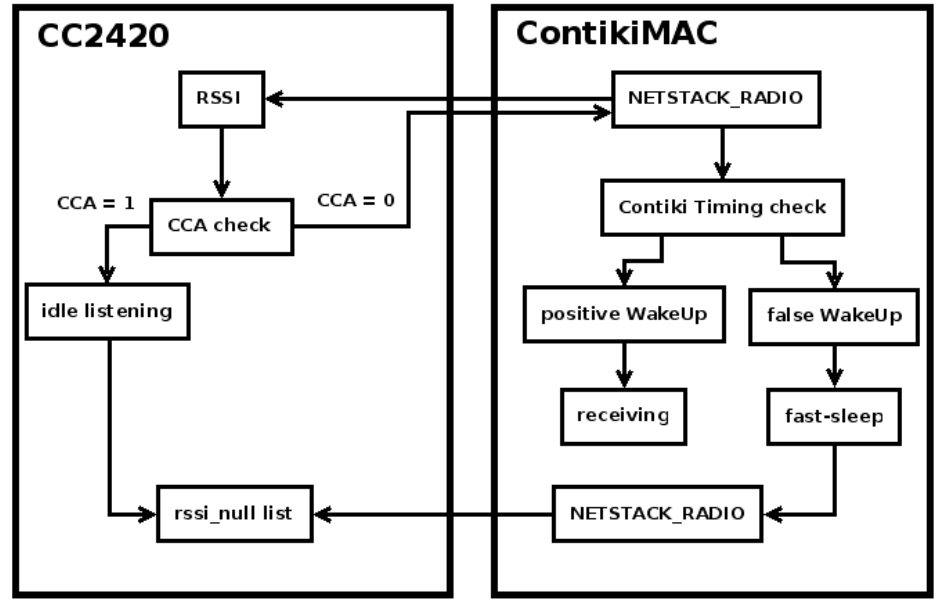
Figure 7. RSSIs classified as null.